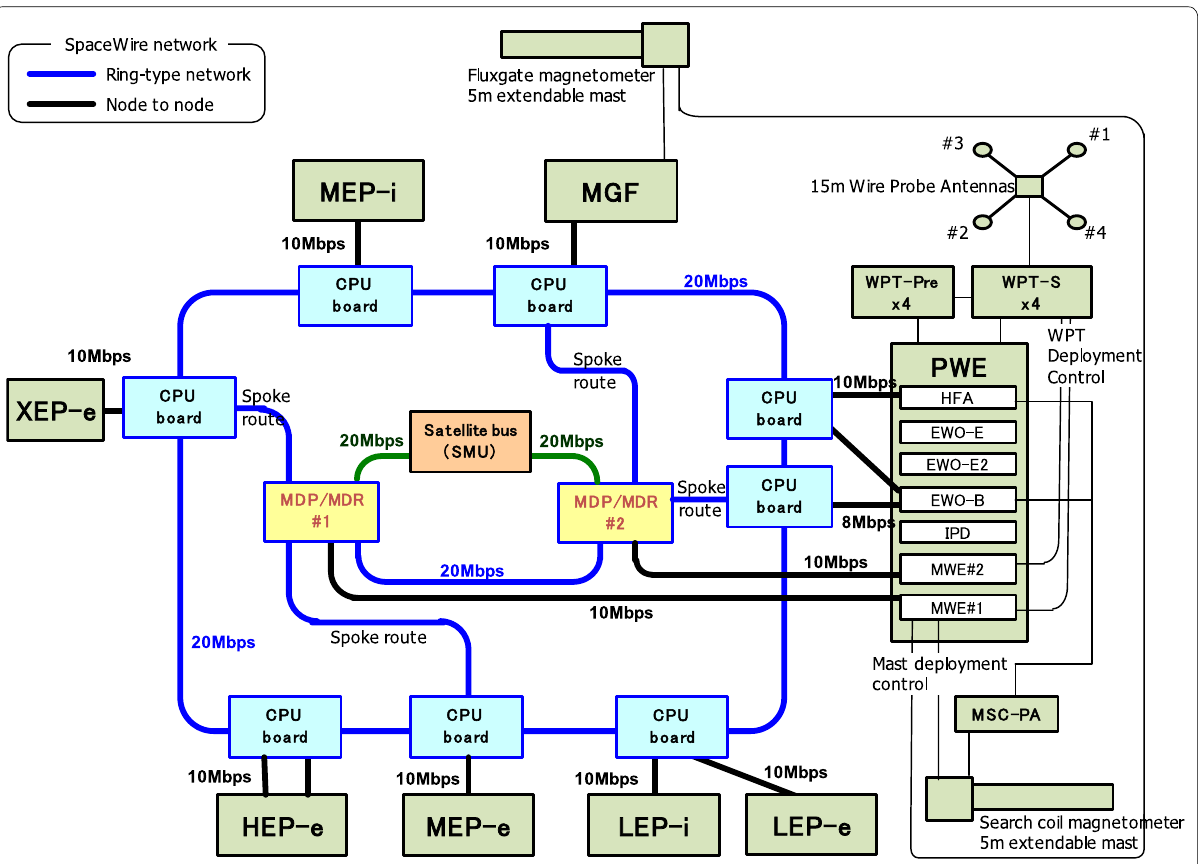
Fig. 9 Mission SpaceWire network in which each instrument has a CPU board that has functionalities of a SpaceWire router and data processor. This architecture enables high‑speed data sharing within the mission components for integrated data analysis and system‑level